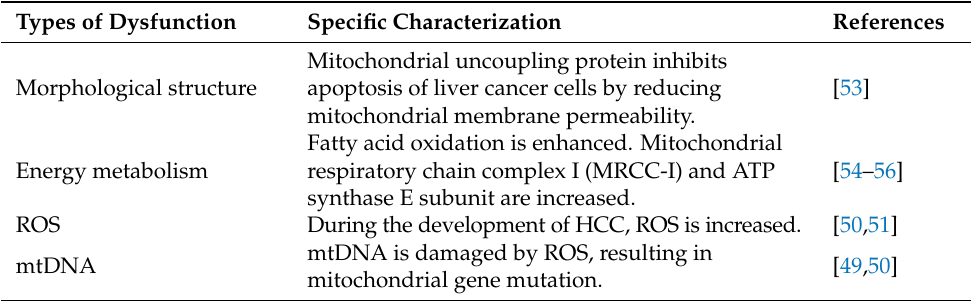
Table 4. Characterizations of mitochondrial dysfunction in